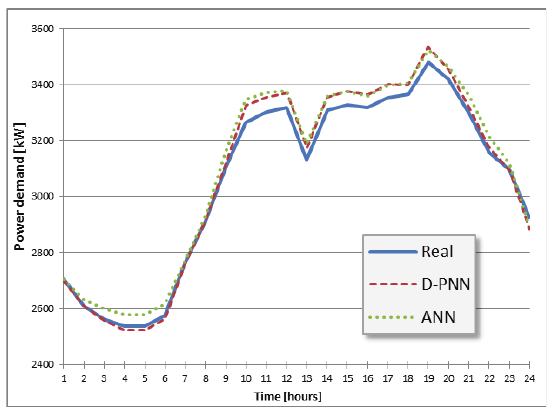
Fig. 5. TEPCO : 7.2.2013 (Tuesday). D-PNN RMSE = 134.9 , ANN RMSE = 161.6